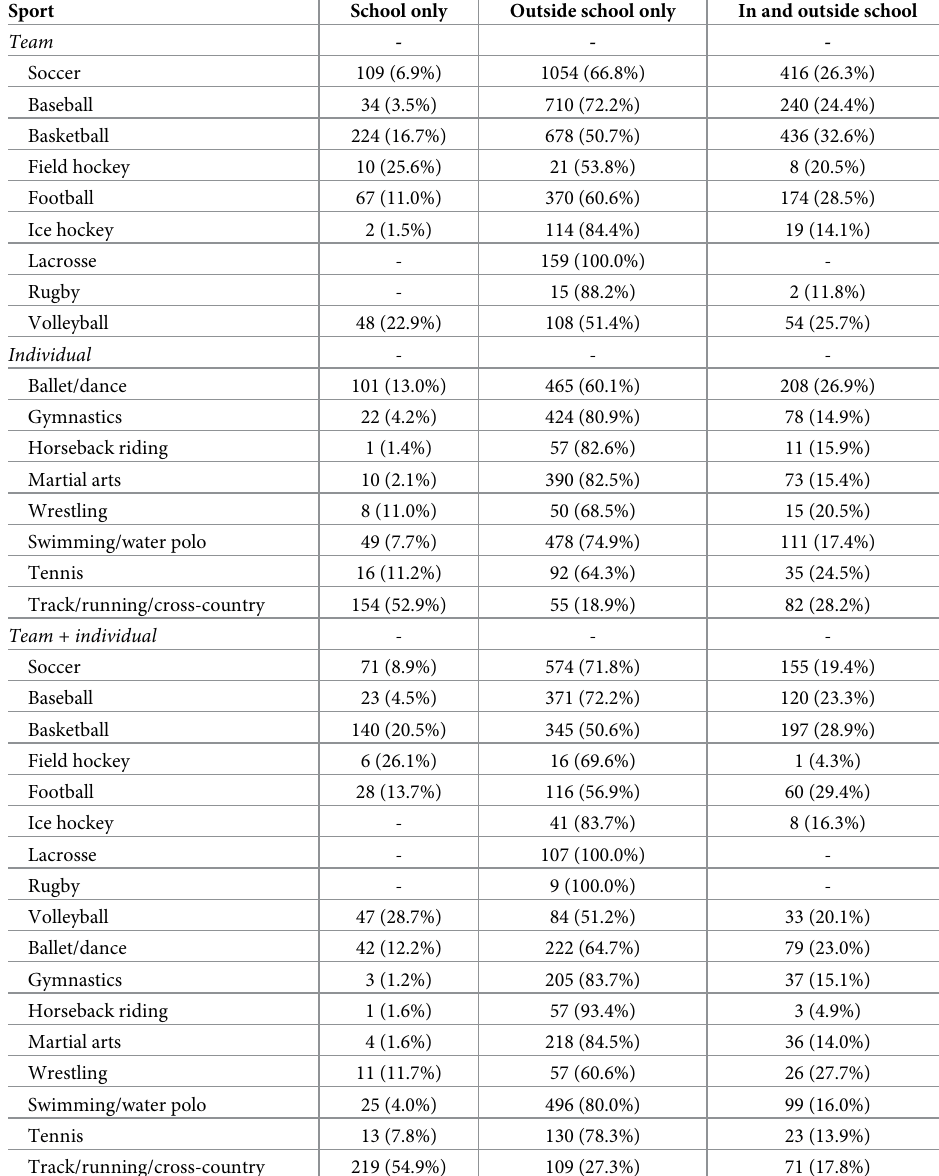
Table 2. Number of participants stratified by sport and